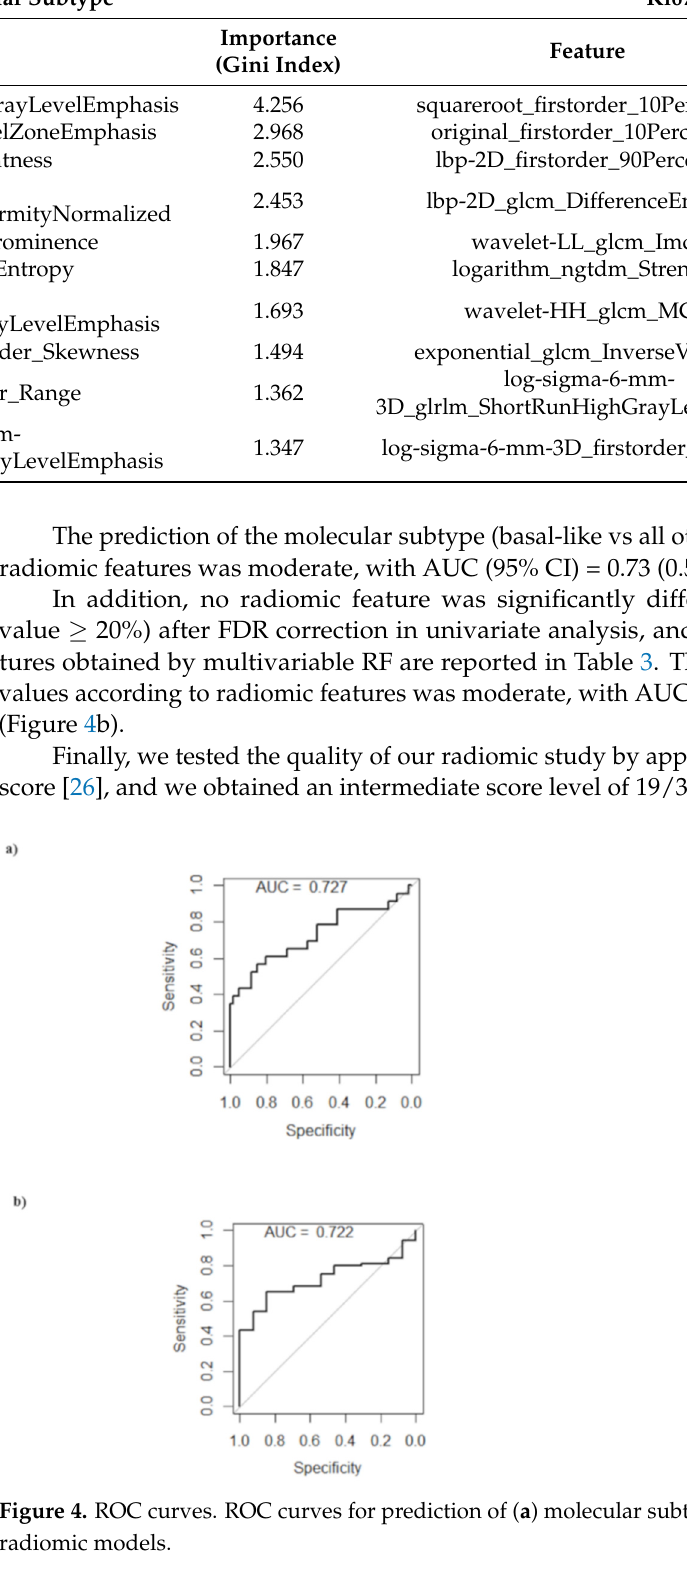
Table 3. Top 10 radiomic variables obtained from the random forest for prediction of molecular subtype and Ki67.